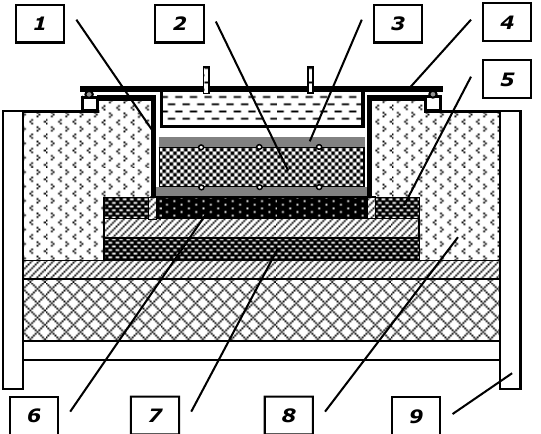
Figure 4. Scheme of the heating chamber: 1—retort with a hot plate; 2—investigated sample; 3—cold plate; 4—heating chamber cover with a cooler; 5—side-guarded heater; 6—main heater; 7—bottom-guarded heater; 8—thermal insulation; 9—support structure.